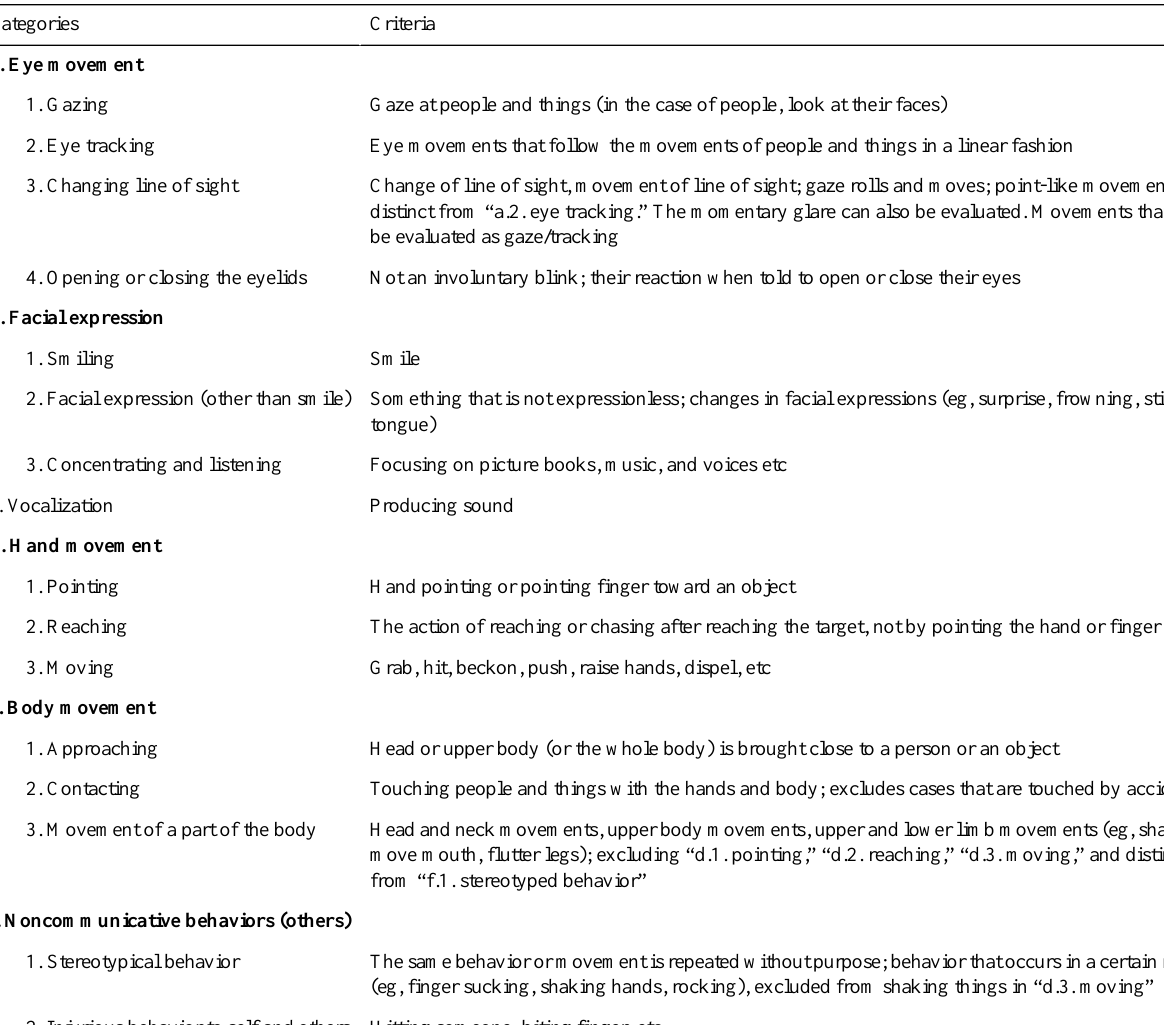
Table 1. Category table of expressions in children with profound intellectual and multiple disabilities or severe motor and intellectual disabilities [14].